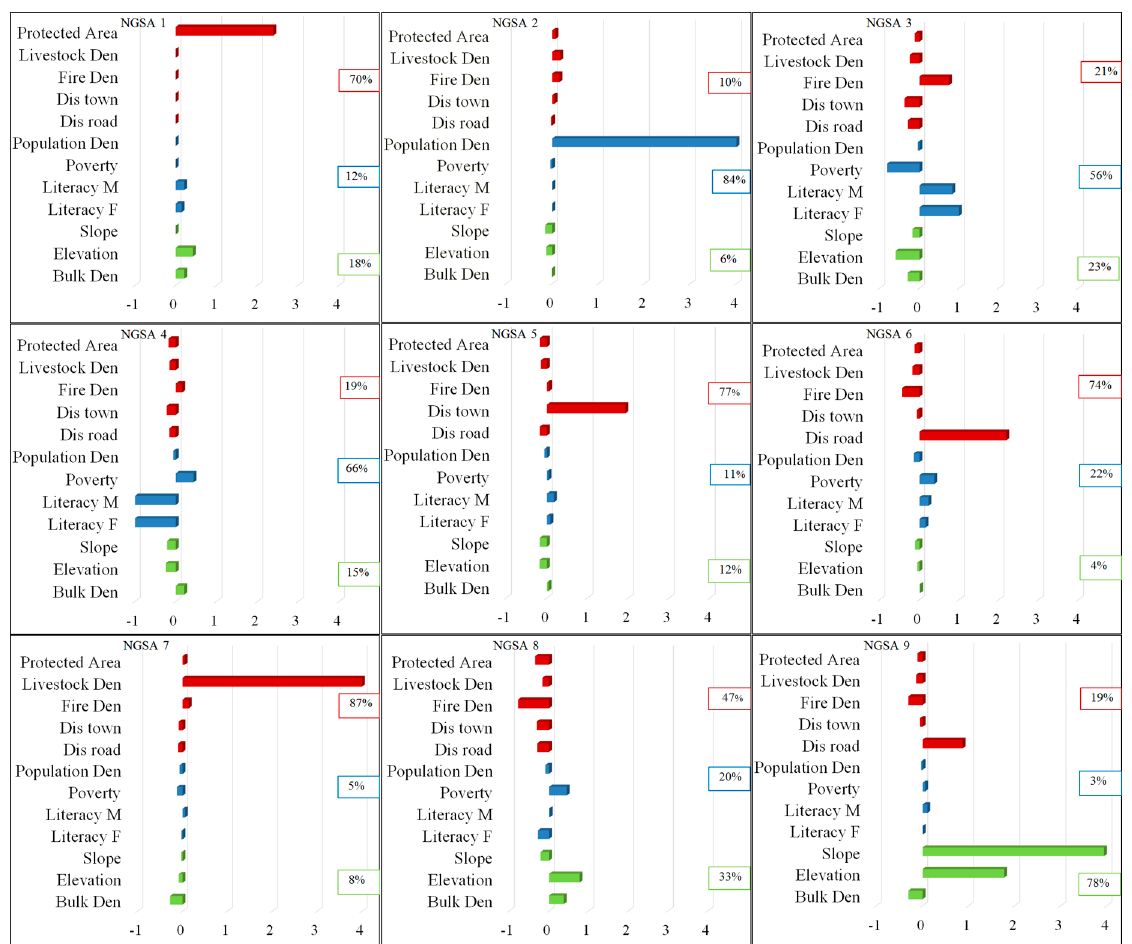
Figure 5. The Z-score normalized values of drivers characterizing the nine archetypes of LD drivers, (zero depicts the mean for the NGS; the percentage contribution of driver categories into archetype clusters is presented in the boxes: red: land-use management practice; blue: socio-economic; green: environmental drivers).